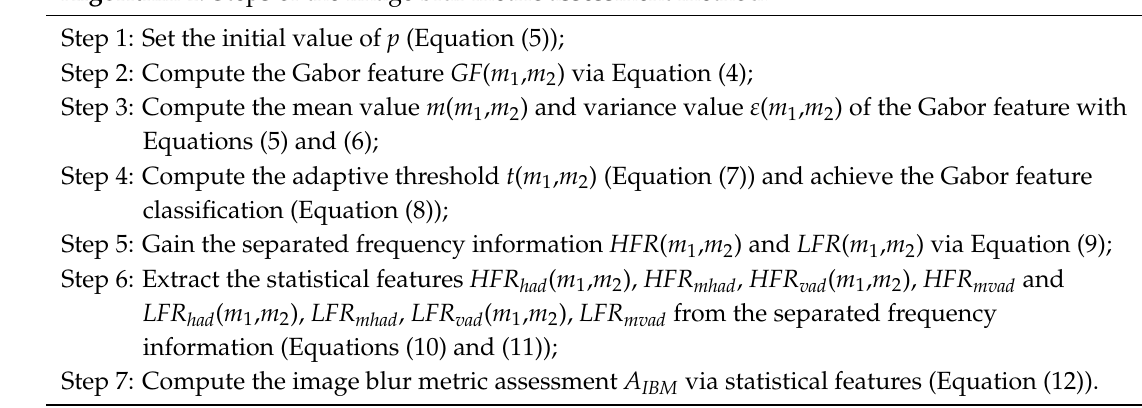
Algorithm 1. Steps of the image blur metric assessment method: